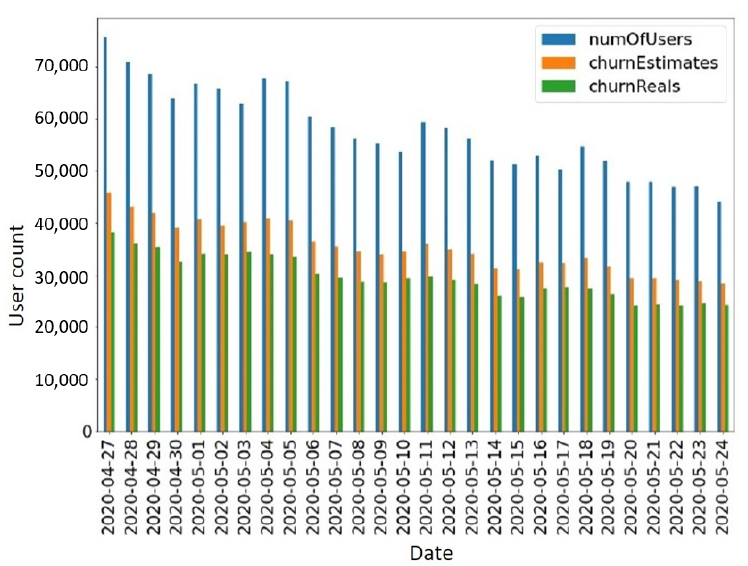
Figure 2. Illustration of player churn estimates based on player activity on the day following game installment as compared to ground truth data considering player activity over a 14-day period.